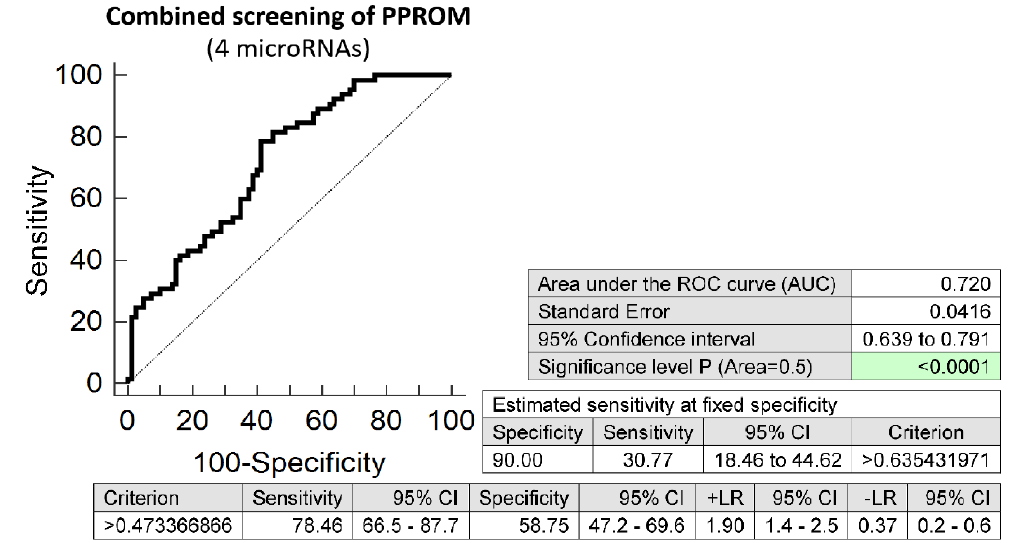
Figure 6. ROC analysis—the best combination of microRNA biomarkers in early prediction of preterm prelabor rupture of membranes. The combination of miR-24-3p, miR-92a-3p, miR-155-5p, and miR-210-3p showed that at 10.0% FPR 30.77% PPROM pregnancies had aberrant microRNA expression profile in the whole peripheral venous blood in early stages of gestation.